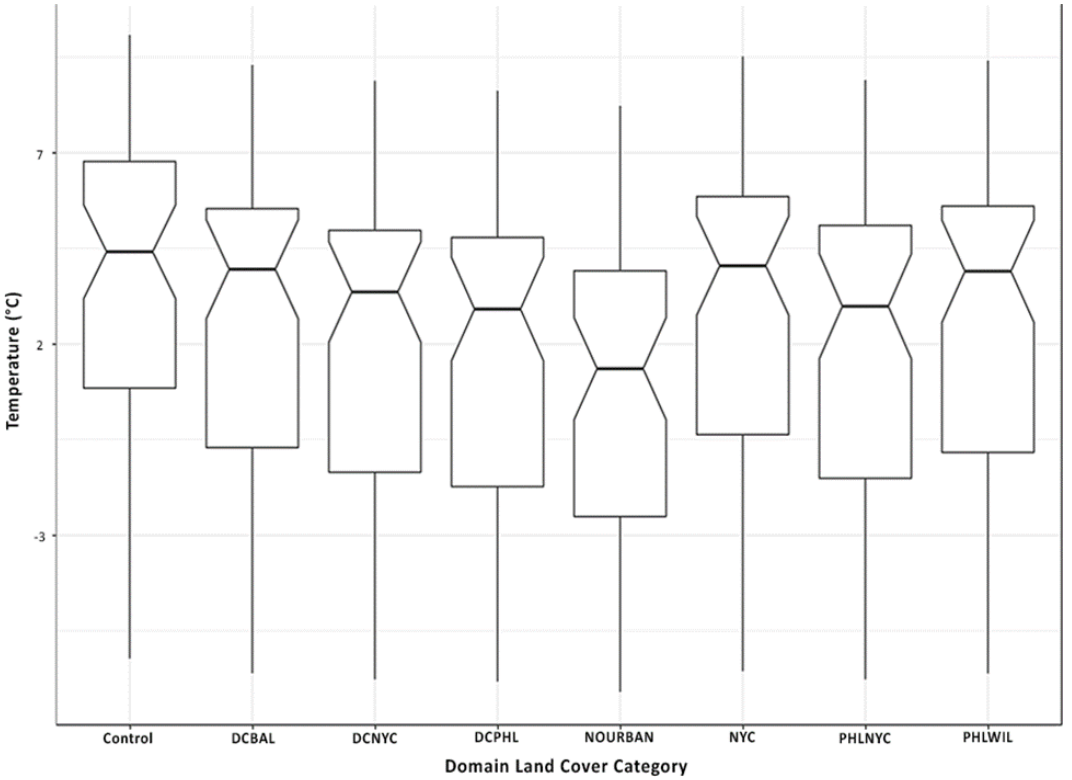
Figure 6. Comparison of 2-m temperature distribution over the masked urban grid points after precipitation onset in the domain. Valid period beginning at 1800 UTC on 5 February 2004.